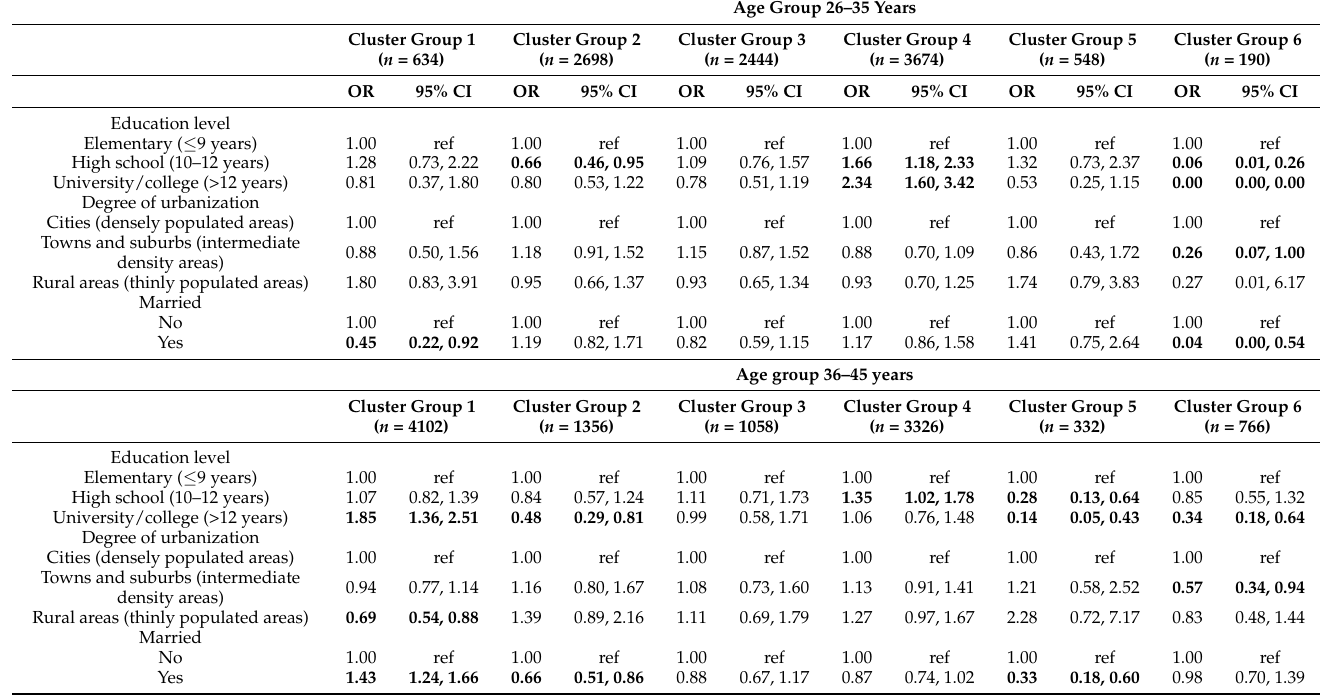
Table 3. Conditional odds ratios (OR) with 95% confidence intervals (CI) for associations between sociodemographic factors and sequence clusters among the age cohorts 26–35 years and 36–45 years of age. Age Group 26–35 Years Cluster Group 1 Cluster Group 2 ( n = 634) ( n = 2698)